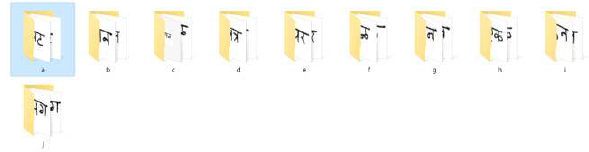
Fig. 2 . Folders of Dataset of Alphabet-wise words